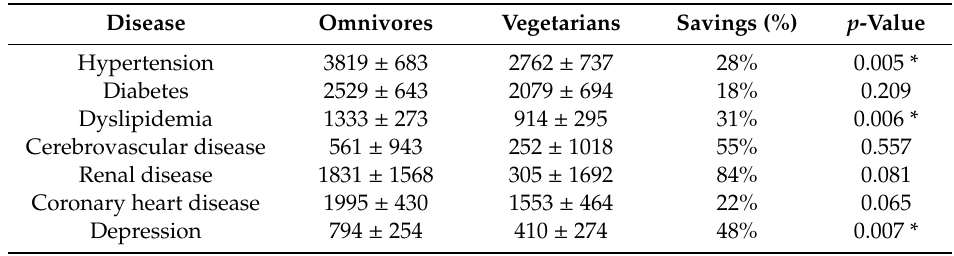
Table 4. Comparison of annual medical expenditure of common diseases between omnivores and vegetarians.